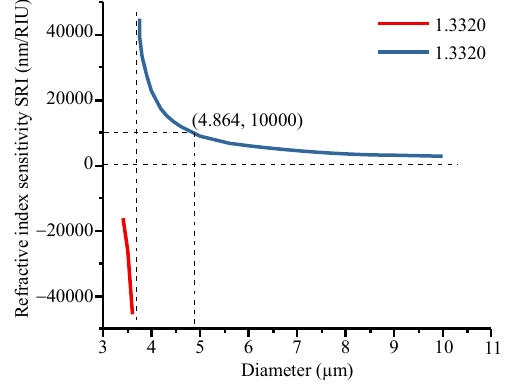
Fig. 4 Refractive index sensitivity when the external refractive index is 1.3320.